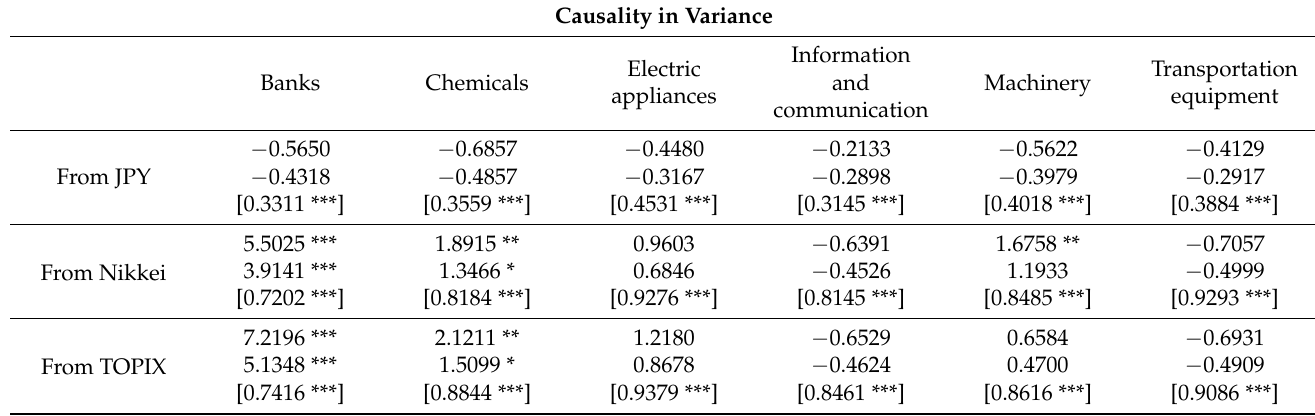
Table 5. Causality from JPY, Nikkei, and TOPIX to sectoral indices. Author’s estimations. First line reports Hong’s (2001) Q-statistics with truncated kernel. Second line reports Hong’s (2001) Q-statistics with Bartlett kernel. Third line reports cross-correlation coefficients at lag 0 (contemporaneous correlation). ***, ** and * indicate that the null hypothesis of no causality (from lag 1 to lag 10 for Hong’s (2001) Q-statistics) at the 1%, 5%, and 10% significance levels, respectively, is